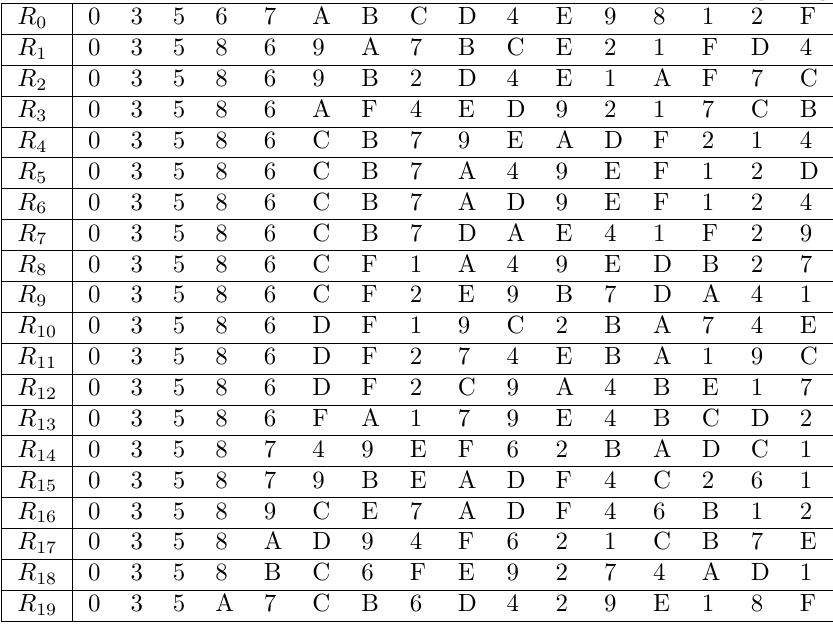
Table 12: Representatives for all 20 classes of Serpent-type S-boxes [LP07]